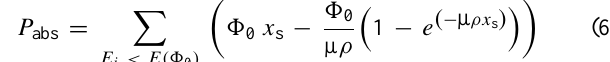
Fig. 8. Relative calibration curve S rel of K α lines for measure- ments at HASYLAB: count rates relative to the count rates of the reference element Cd are plotted versus atomic number Z with the corresponding fit. Theoretical curves for the fluorescence yield as calculated with Eq. (5), absorbed photon fraction as calculated with Eq. (6) (estimation for experimental conditions taking into account the HASYLAB excitation spectrum with a 8-mm Al absorber) and detector efficiency are shown on the same axis scale. The lower end of the detector efficiency is depicted by Z 0 in the plot, i.e. the value of Z where the detector efficiency reaches zero.